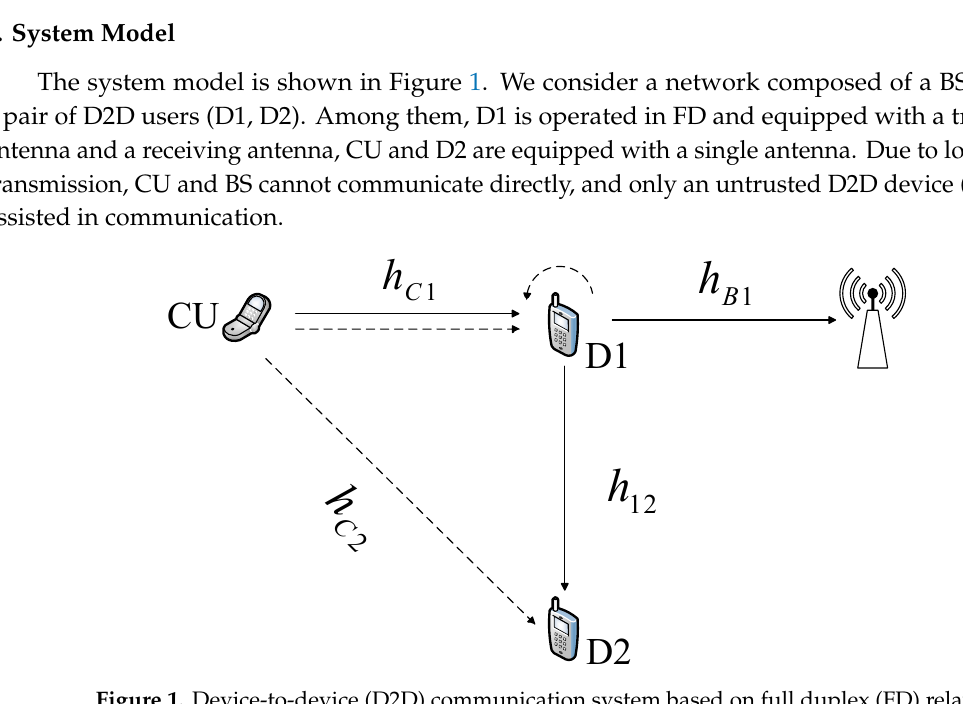
Figure 1. Device-to-device (D2D) communication system based on full duplex (FD) relay.